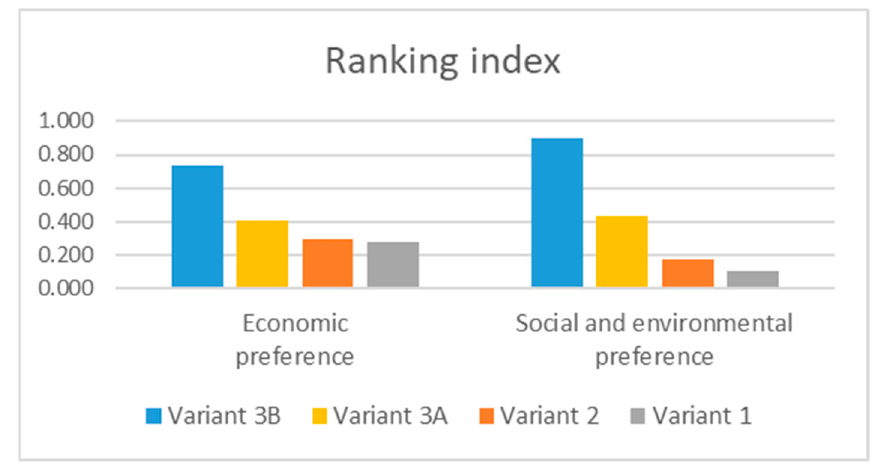
Figure 4. Final ranking of variants.